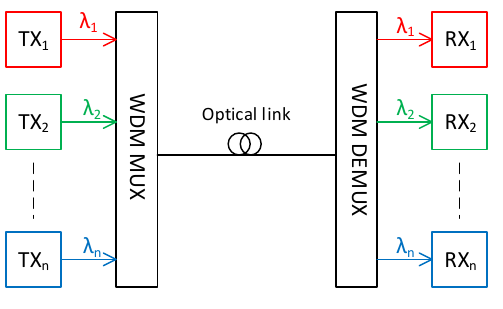
Figure 4. Principle of WDM in a